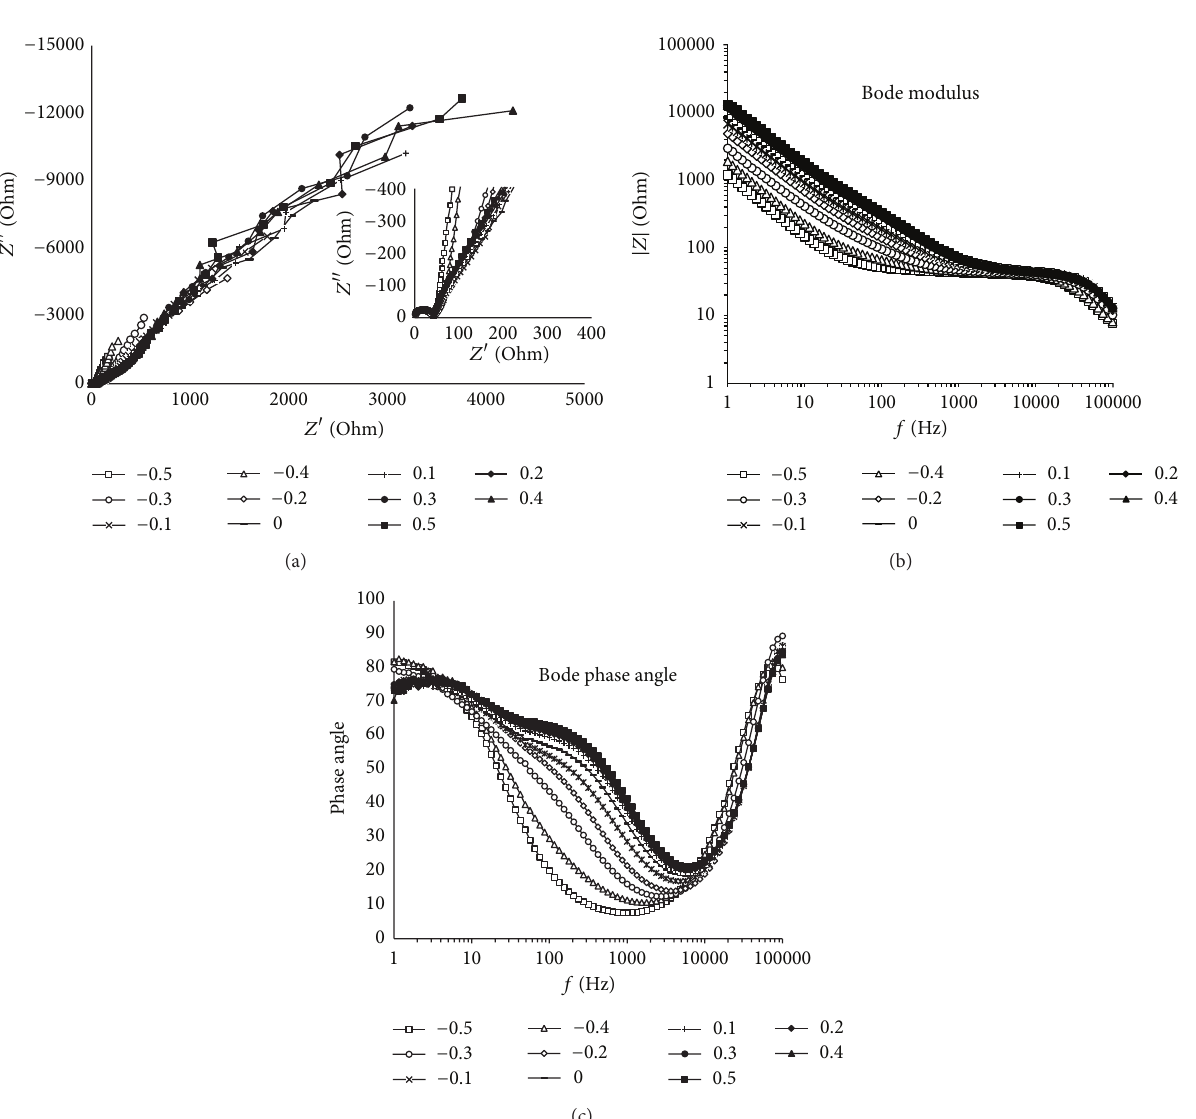
Figure 4: EIS spectra of NT sample, recorded at different bias potentials in